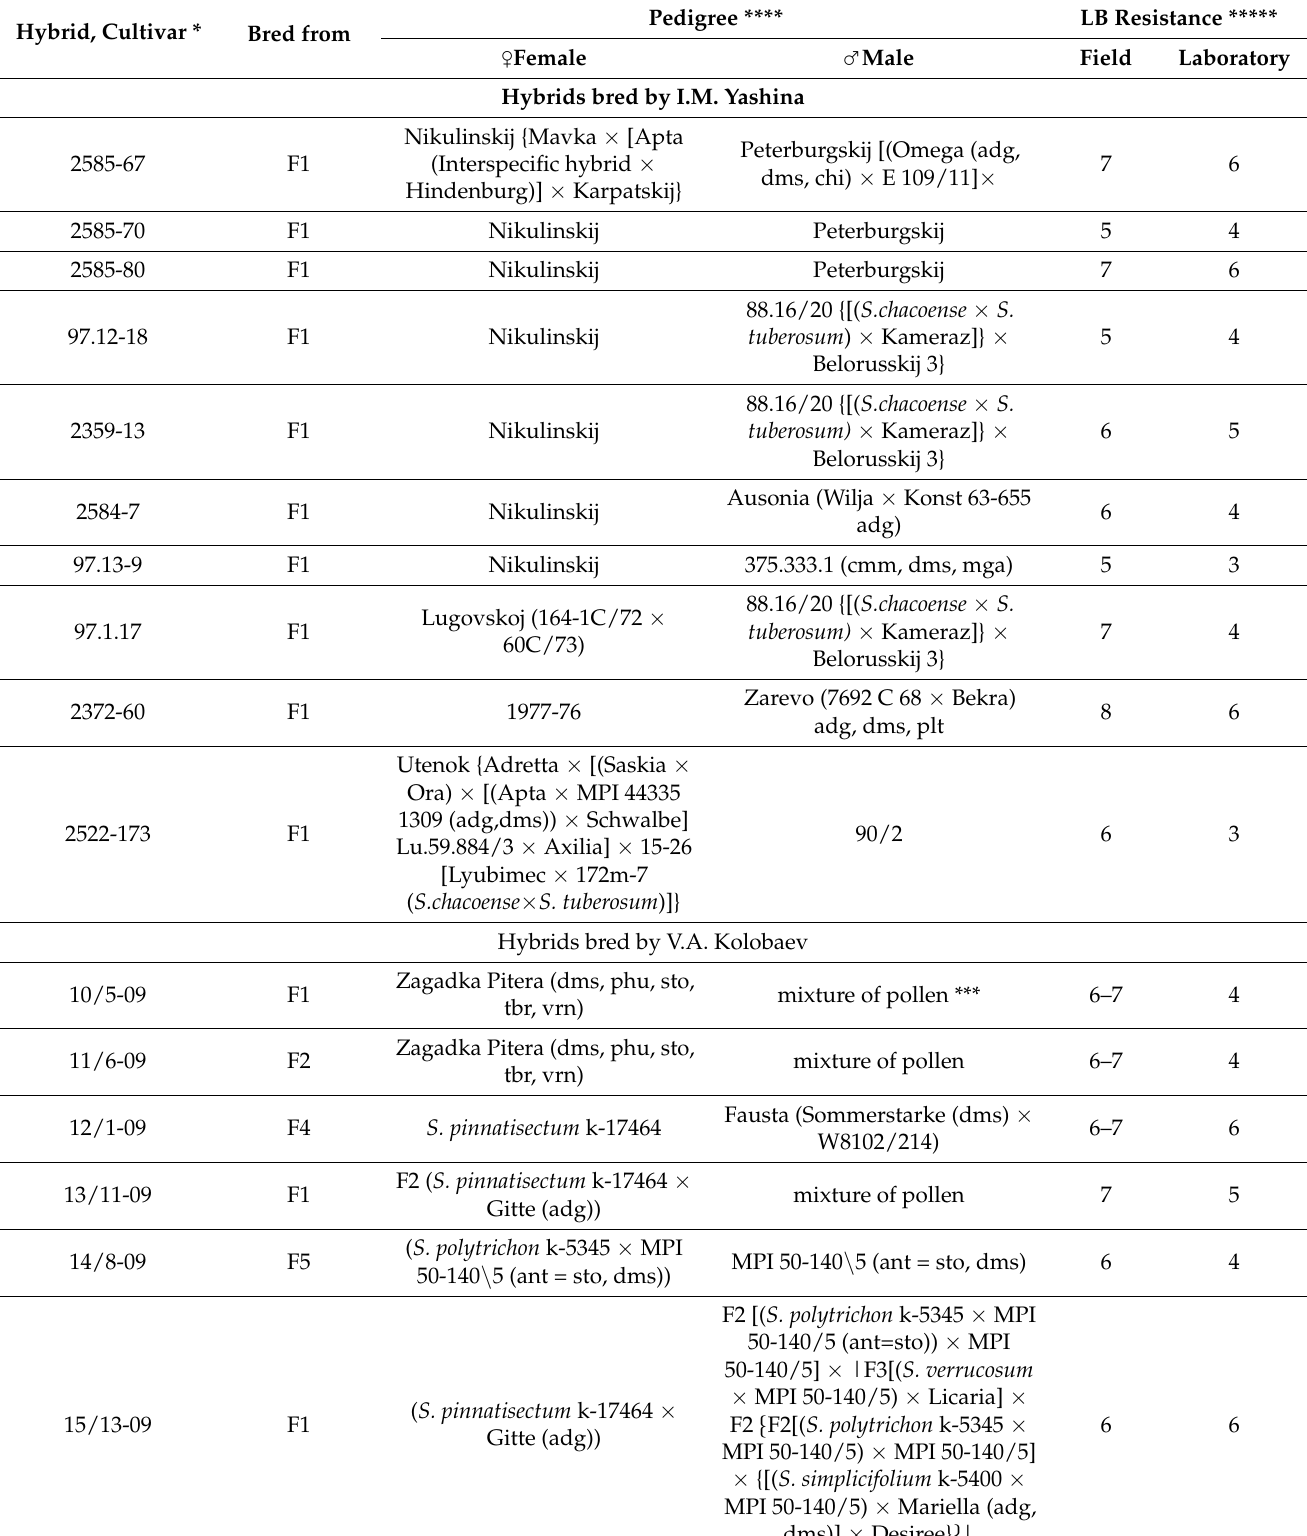
Table 2. Multiparental interspecific hybrids and potato cultivars included in this